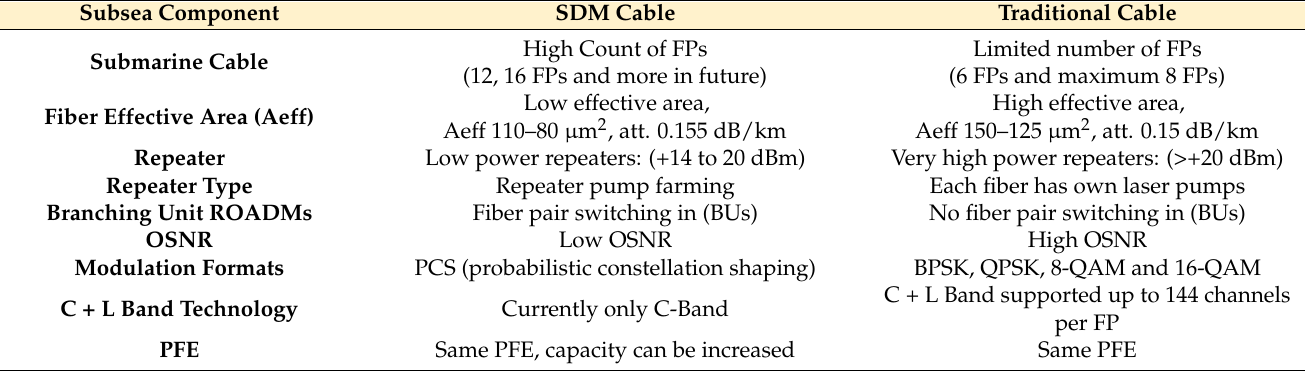
Table 4. A comparison between Traditional and SDM submarine cables